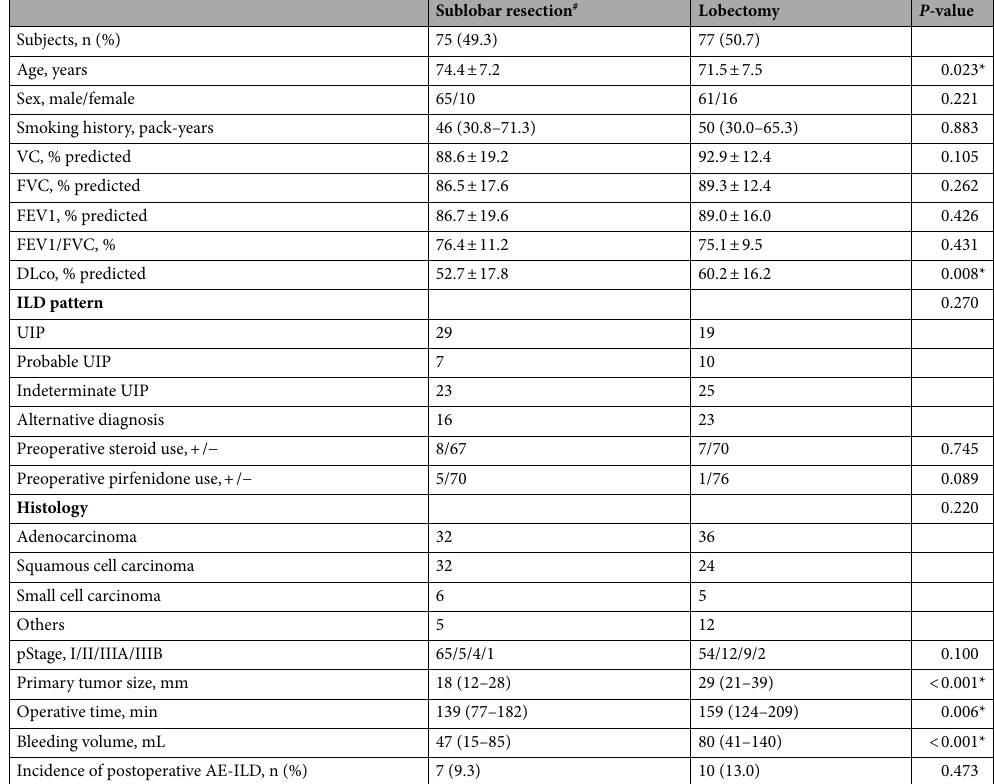
Table 4. Patient characteristics based on the type of surgical intervention. Data are presented as mean ± standard deviation or median (interquartile range) according to their distribution. AE-ILD acute exacerbation of interstitial lung disease; CEA carcinoembryonic antigen; DLco diffusing capacity for carbon monoxide; FEV1 forced expiratory volume in one second; FVC forced vital capacity; ILD interstitial lung disease; UIP usual interstitial pneumonia; VC vital capacity. *All P- values were evaluated by comparing patients with and without postoperative AE-ILD using the t-test and Mann–Whitney U tests for normally and non-normally distributed variables and using Pearson’s chi-squared test. # Sublobar resection group included 41 patients treated with wedge resection and 34 patients treated with